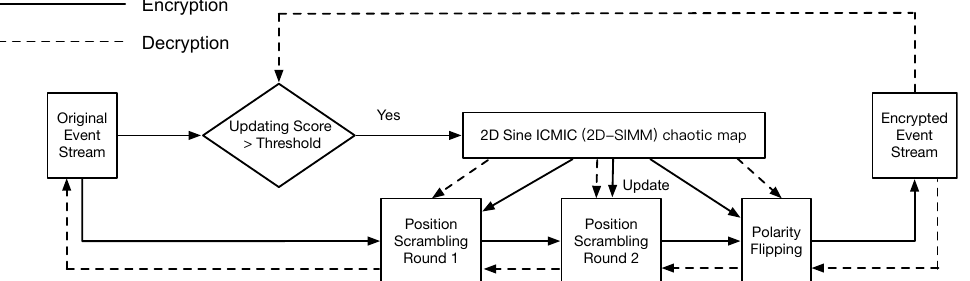
Figure 4. The flowchart of the proposed encryption and decryption framework. The updating score controls the updating speed of pseudo-random sequences, which are generated using chaotic mapping. The encryption (decryption) process consists of scrambling (restoring) positions and flipping (restoring)